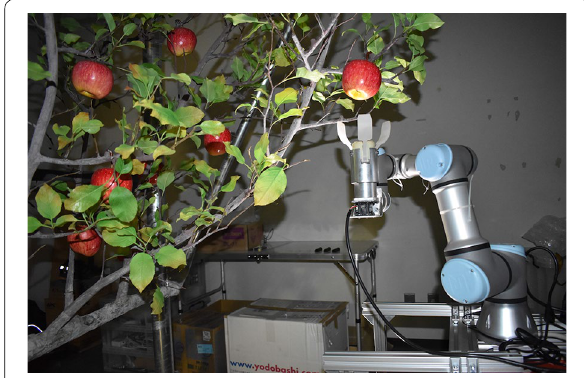
Fig. 14 Approching target